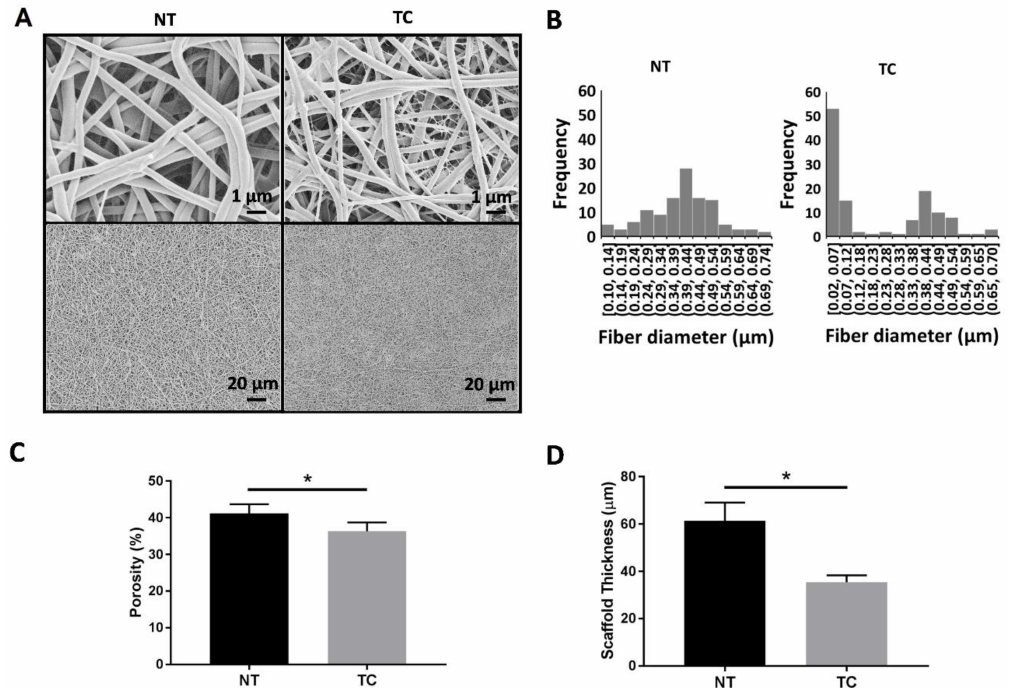
Figure 2. Effect of thermoforming and coating on polycaprolactone/gelatin/fibrinogen scaffolds. ( A ) Representative SEM images of nontreated (NT) or thermoformed and coated (TC) scaffolds. ( B ) Fiber diameter distribution in NT and TC scaffolds was calculated from the SEM images. NT scaffolds have a normal fiber size distribution with fibers ranging from 0.1 to 0.74 µ m. The TC scaffolds have a bimodal fiber size distribution with thin fibers ranging from 0.02 to 0.12 µ m, and thick fibers ranging from 0.12 to 0.7 µ m ( n = 6 scaffolds, 120 fibers). ( C ) Average porosity results calculated from the SEM images show a significant decrease in TC scaffolds (* p < 0.05; n = 6 scaffolds). ( D ) A significant reduction in thickness calculated from multiphoton images was found in the TC group (* p < 0.05; n = 6